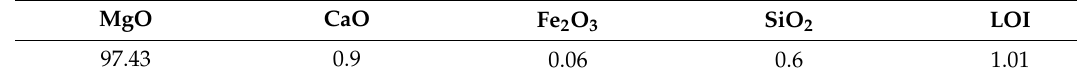
Table 1. Chemical composition (wt.%) of magnesia.